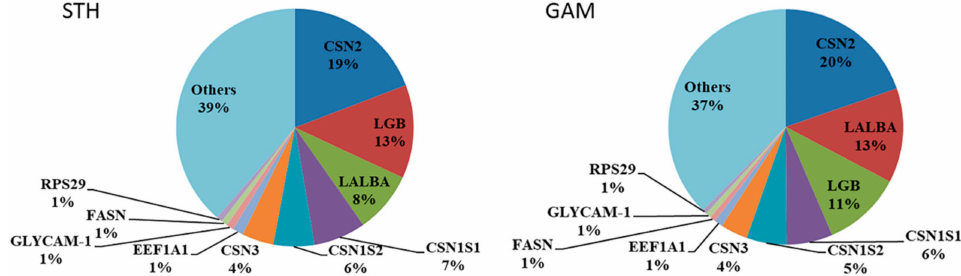
Figure 1. Pie charts of gene reads per kilobase per million (RPKM) in the Small-Tailed Han (STH) and Gansu Alpine Merino (GAM) sheep. A depiction of the genes that were the most highly expressed during lactation in the parenchyma using RNA-Seq analyses. The number below each gene is the proportion of total expression (the RPKM of the specific gene divided by the total RPKM of all genes in the sample).